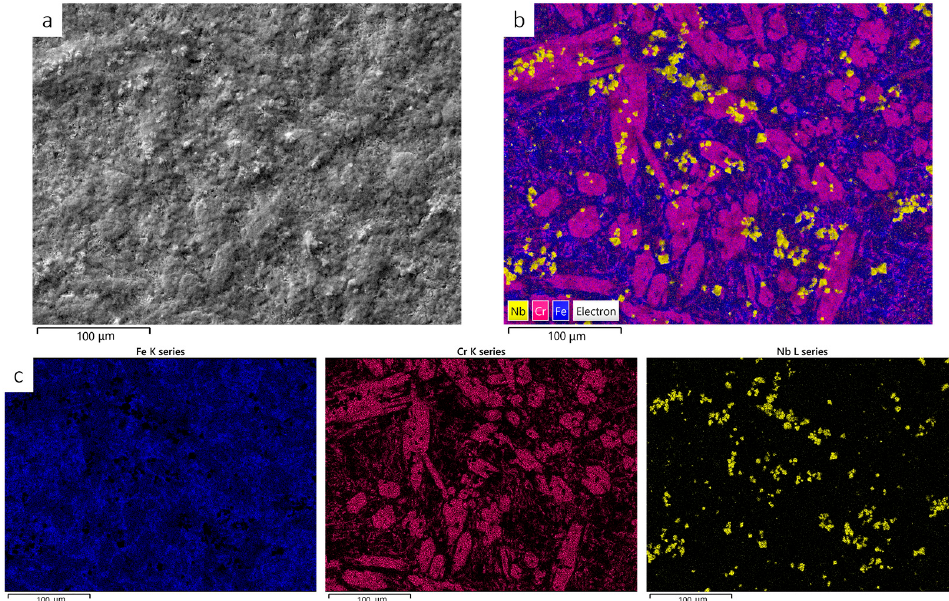
Figure 11. SEM images of the worn surface, center of the crater after 30 min of erosion on an as- received sample: ( a ) SEI-SEM image, ( b ) layered image of X-ray maps, and ( c ) maps of the elemental distribution.